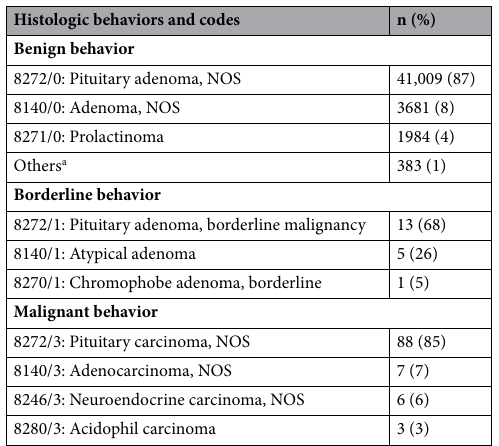
Table 2. Histology and behavior of primary pituitary tumors based on ICD-O-3. NOS Not otherwise specified. a Included chromophobe adenoma (8270/0), acidophil adenoma (8280/0), basophil adenoma (8300/0), monomorphic adenoma (8146/0), mixed acidophil-basophil adenoma (8281/0), mixed cell adenoma (8323/0), and macrofollicular adenoma (8334/0).